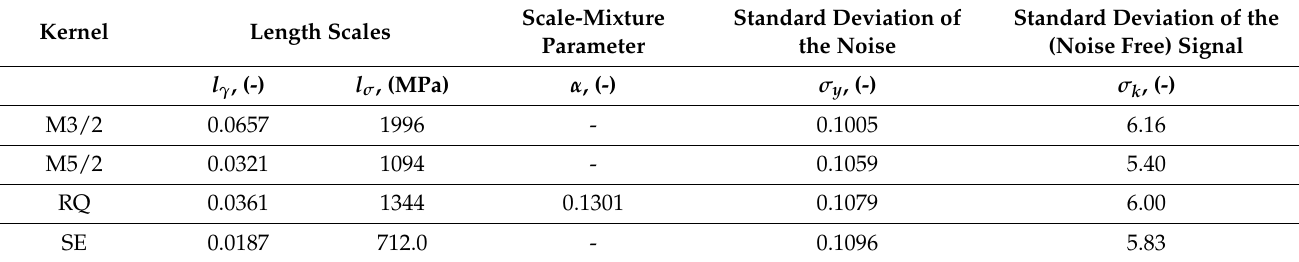
Table 4. Hyperparameters of the covariance functions for the second training